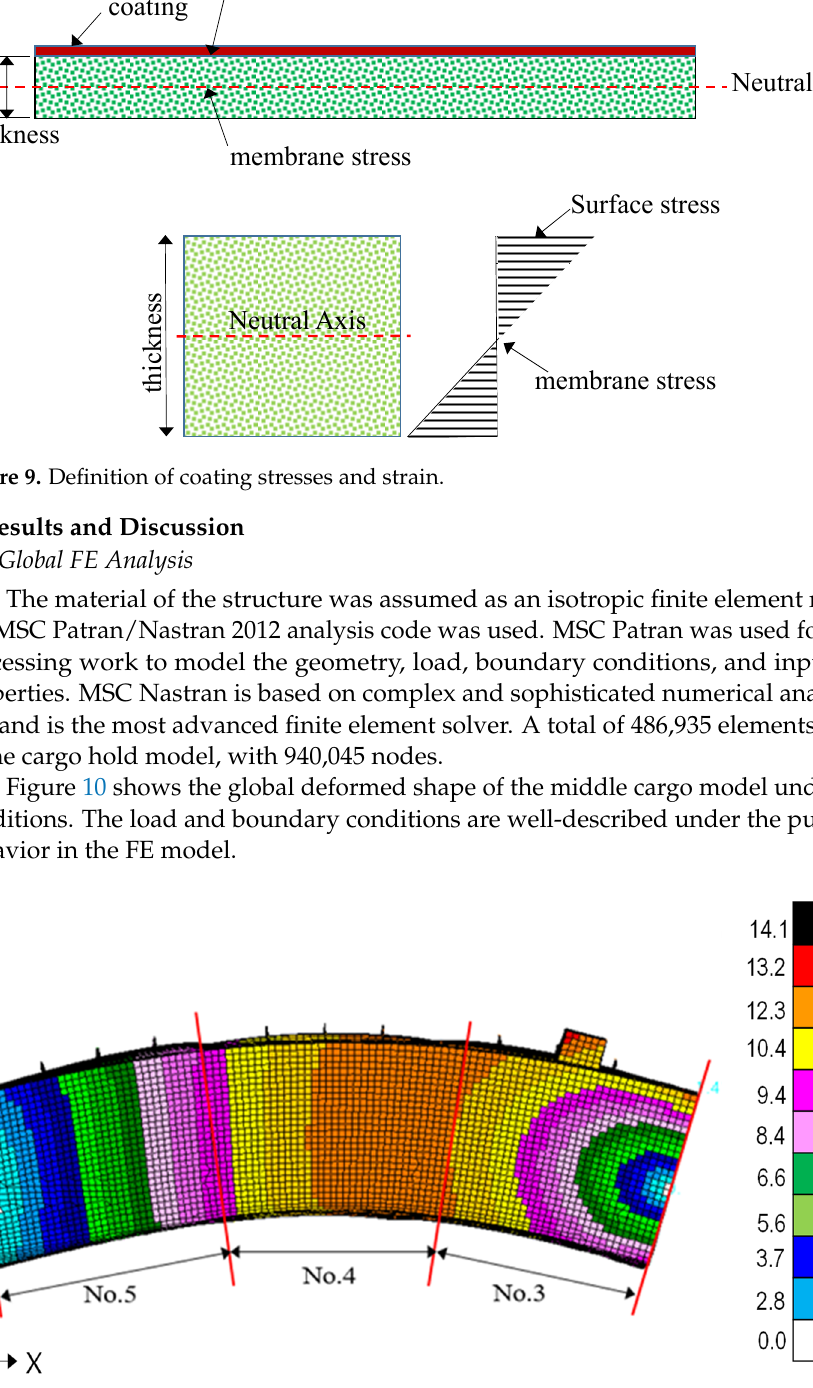
Figure 10. Deformed shape and displacement of three cargo hold models under hogging conditions (unit: mm).